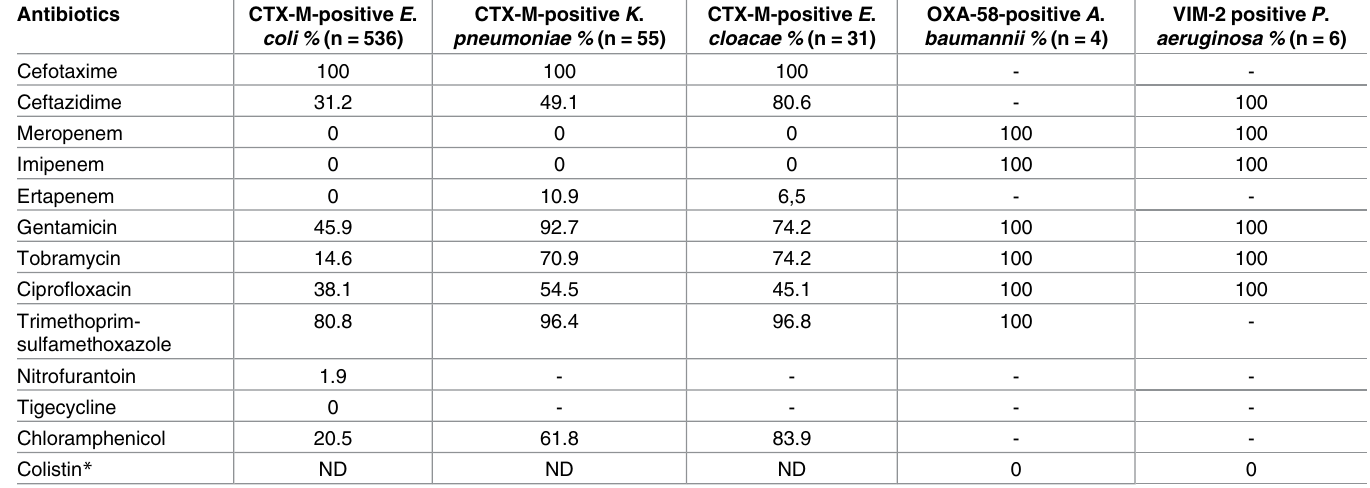
Table 4. Resistance rates of relevant Gram-negative multidrug-resistant bacteria. Antibiotics CTX-M-positive E . coli % (n =